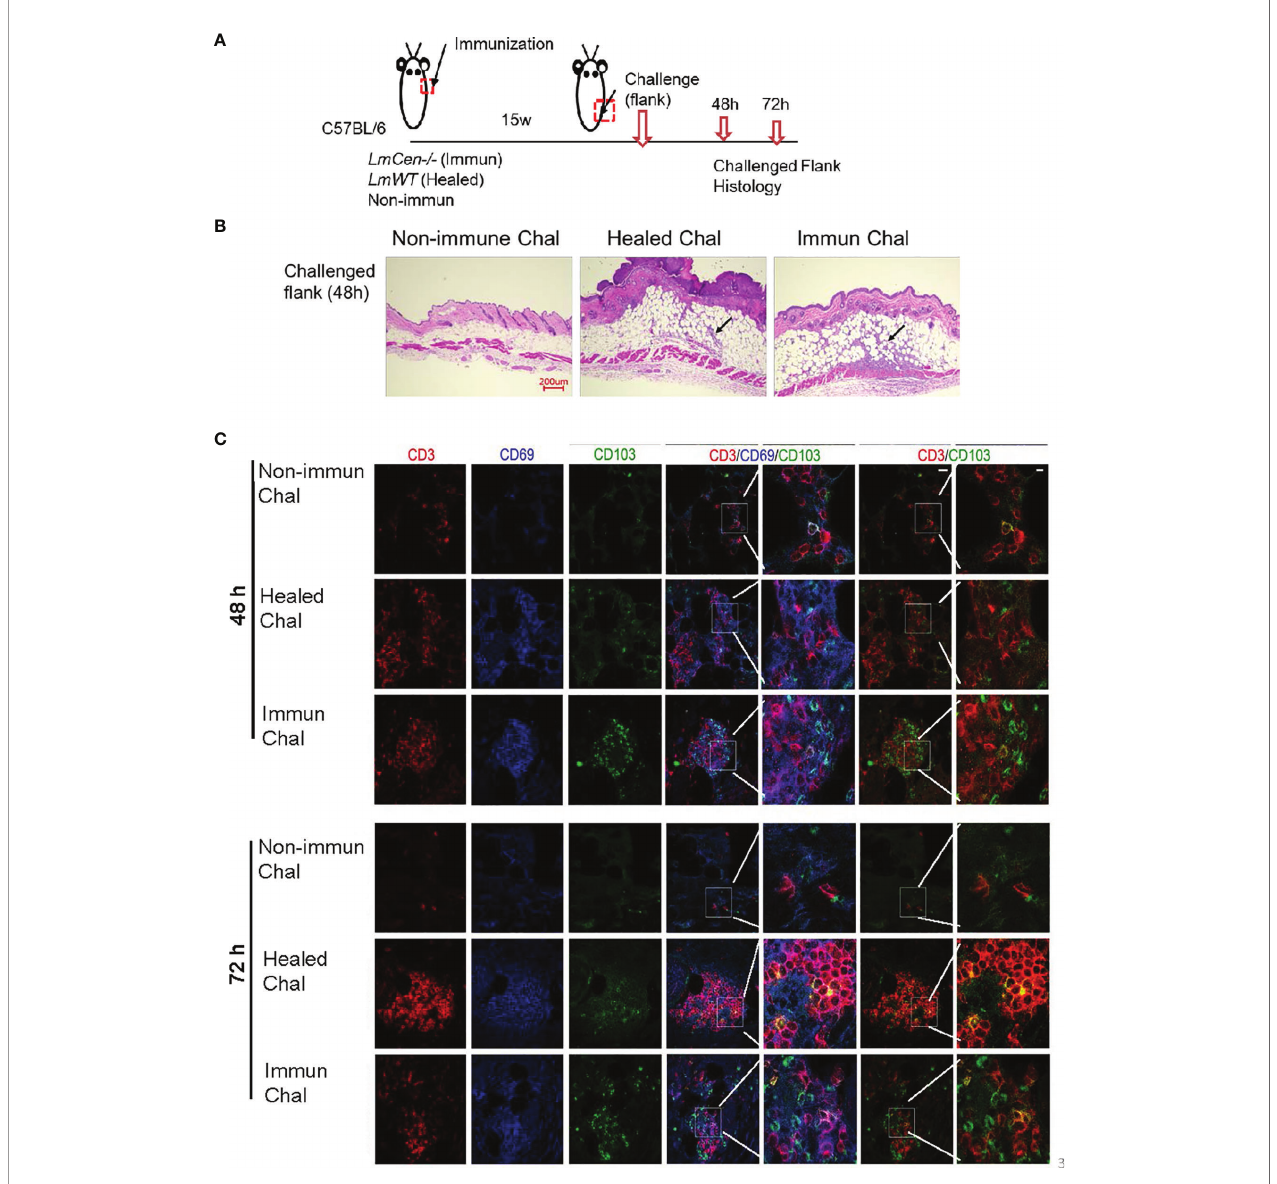
FIGURE 3 | LmWT challenge leads to rapid accumulation of TRM cells in the skin of immunized or healed mice. Fifteen-week (15w) immunized and healed mice and non-immunized control mice were challenged in the fl ank skin with LmWT virulent parasite. Skin from the site of challenge was collected at 48 and 72 hours (48h and 72h) post-challenge. Tissue in fi ltration and TRM cells were analyzed by immuno fl uorescence and H&E staining. (A) Schematic plan of the experimental time points. (B) H&E staining of skin tissue at the site of challenge 48 h post-challenge. Black arrow indicates cellular in fi ltration at the challenge site. (C) Expression of CD3 (red), CD69 (blue), and CD103 (green) in the fl ank skin of non-immunized control, healed, and immunized mice, at the site of challenge, following 48 and 72 h post-challenge. Scale bar is 25 µm. Results are representative of one independent experiment, repeated 3 times, with 3 mice per